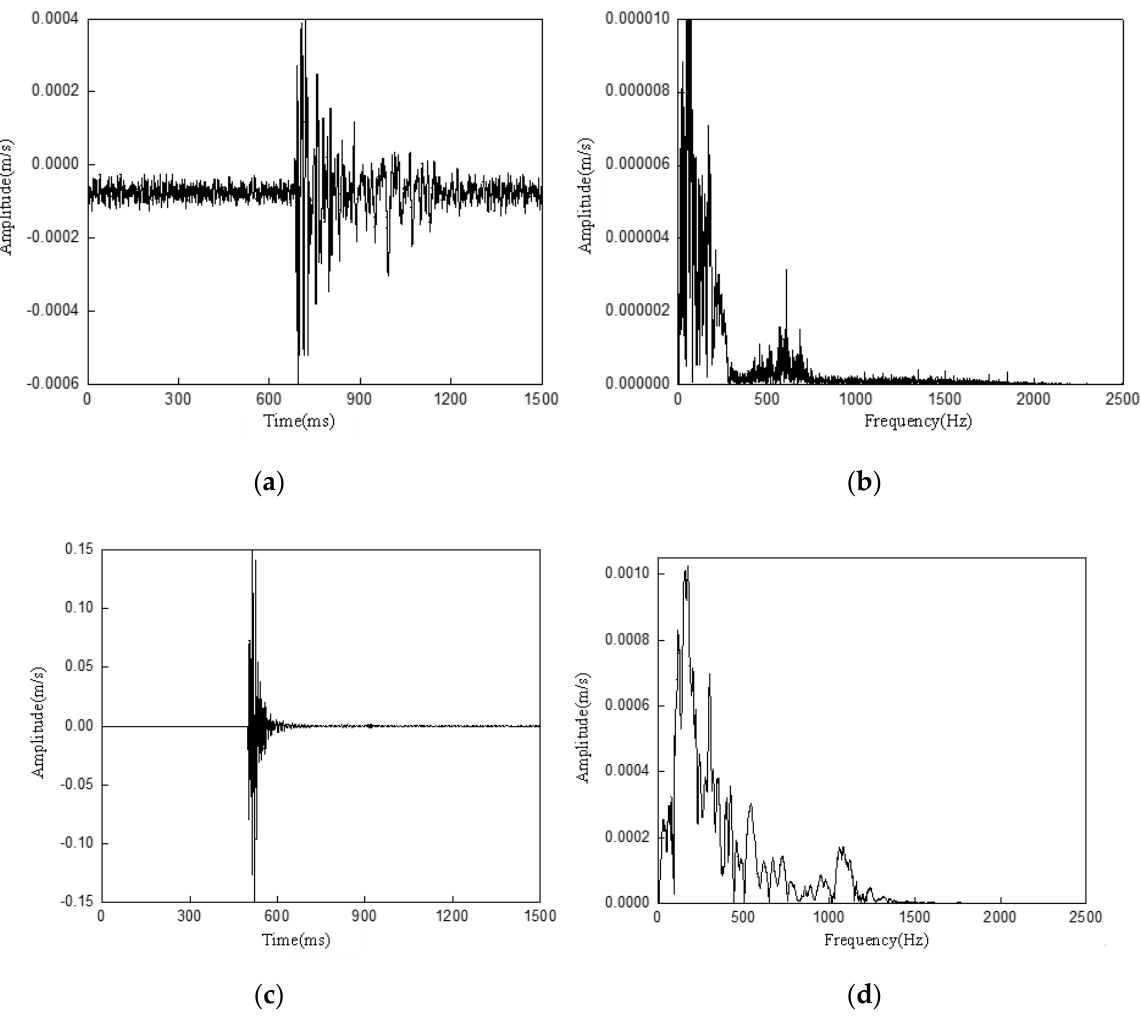
Figure 6. Typical microseismic signals and their frequency spectra in mines. ( a ) Coal-and-rock- mass-rupture signal; ( b ) Coal-and-rock-mass-rupture-signal frequency; ( c ) Blasting-vibration signal; ( d ) Blasting-vibration-signal